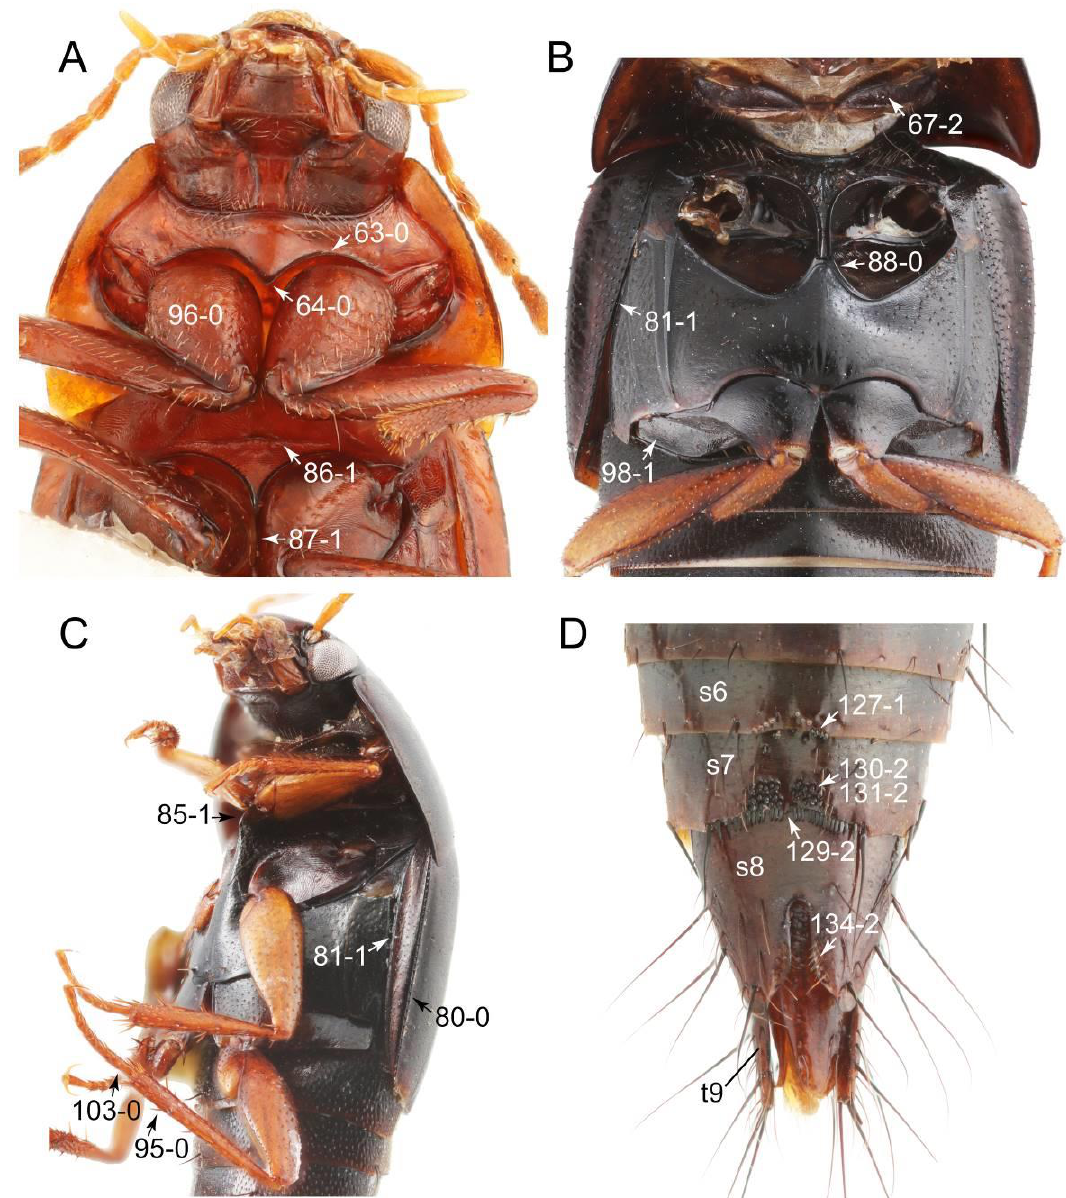
Figure 52. Photographs of body parts of Tachinusini, enlarged. ( A ) forebody of Leucotachinus luteonitens , ventral view. ( B ) mesothorax and metathorax of Tachinoplesius latipennis , ventral view. ( C ) forebody of Tachinomorphus grossulus , ventrolateral view. ( D ) male abdomen of Nitidotachinus tachyporoides , ventral view. Abbreviations: s6–8, sternite s6–8; t9, tergite IX. Characters and character states (format X-X) are indicated on each